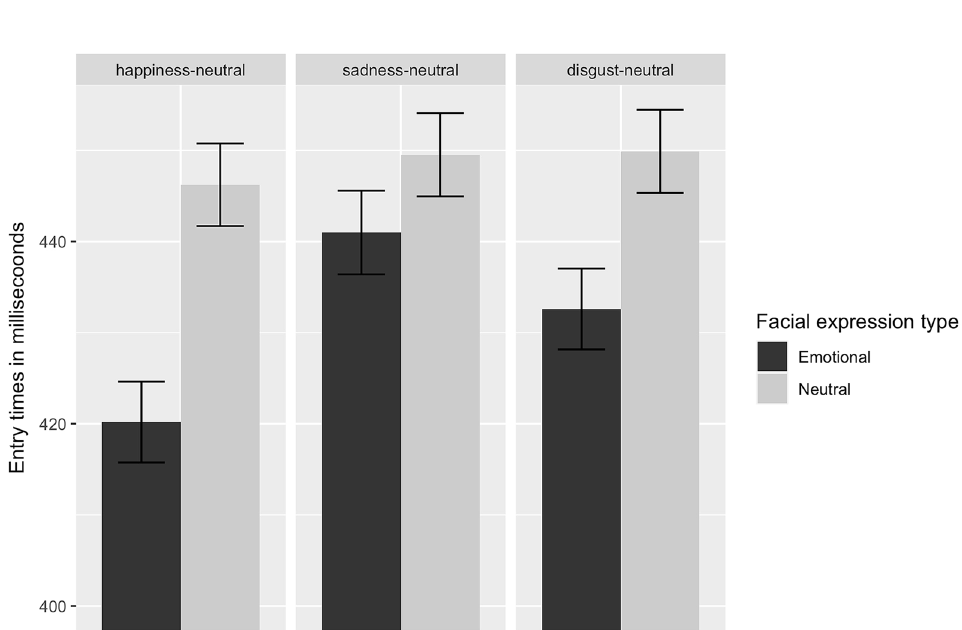
Figure 4. Entry times on the emotional and neutral facial expressions in ms for happy-, sad-, and disgusted- neutral facial expression pairs. Error bars denote standard